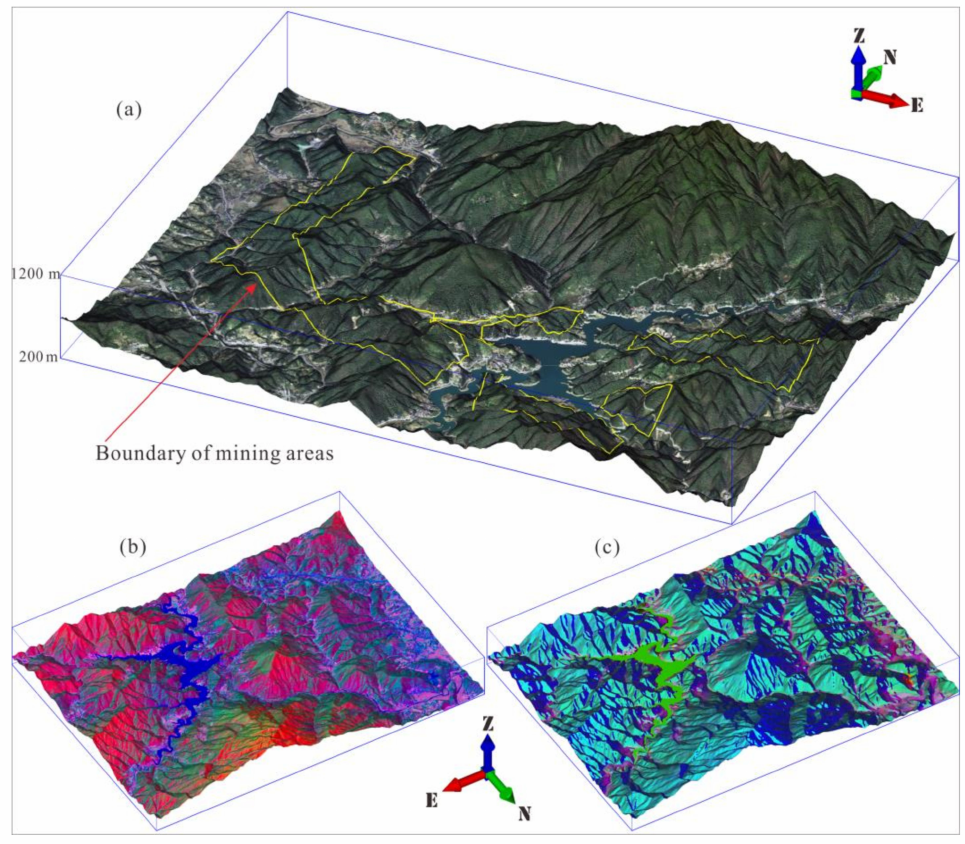
Figure 10. The 3D visualization of the terrain surface, showing the TCI ( a ) and two enhanced PCI ( b , c ) from GF-1/PMS